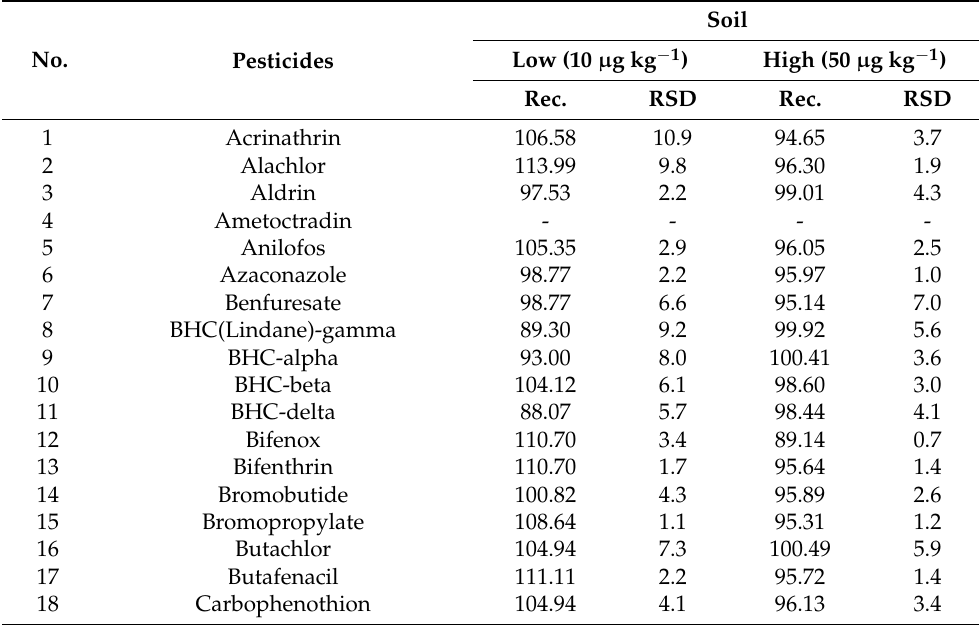
Table 5. Recoveries of the first 40 pesticides in the untreated soil using GC–MS/MS ( n = 3). Recoveries of the other 83 pesticides are listed in Table